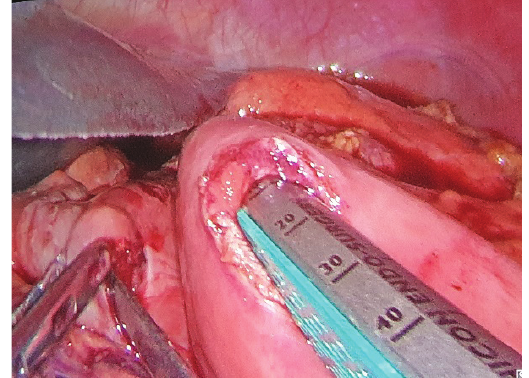
Figure 5: Inner layer sutures of pancreaticojejunostomy